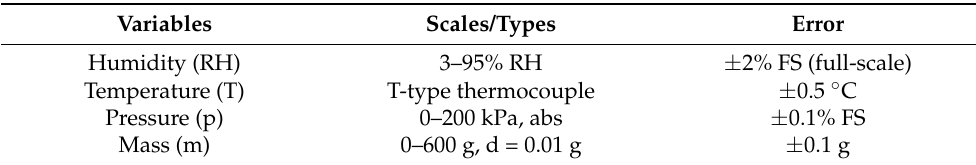
Table 2. Specifications of the sensors used in the